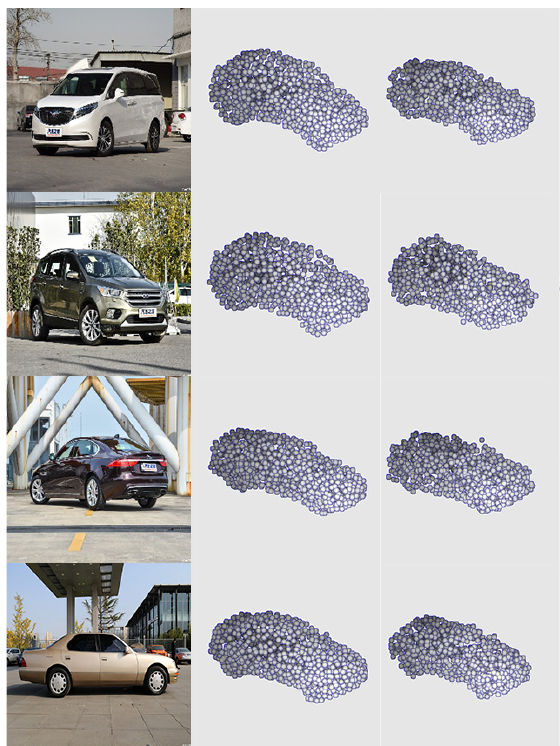
Figure 11. Car images from Internet. The orders from left to right: original images, the results of PCCNet and PSGN